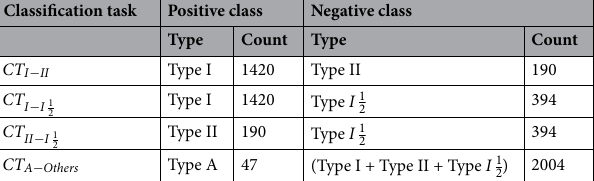
Table 8. Details of the classification tasks.